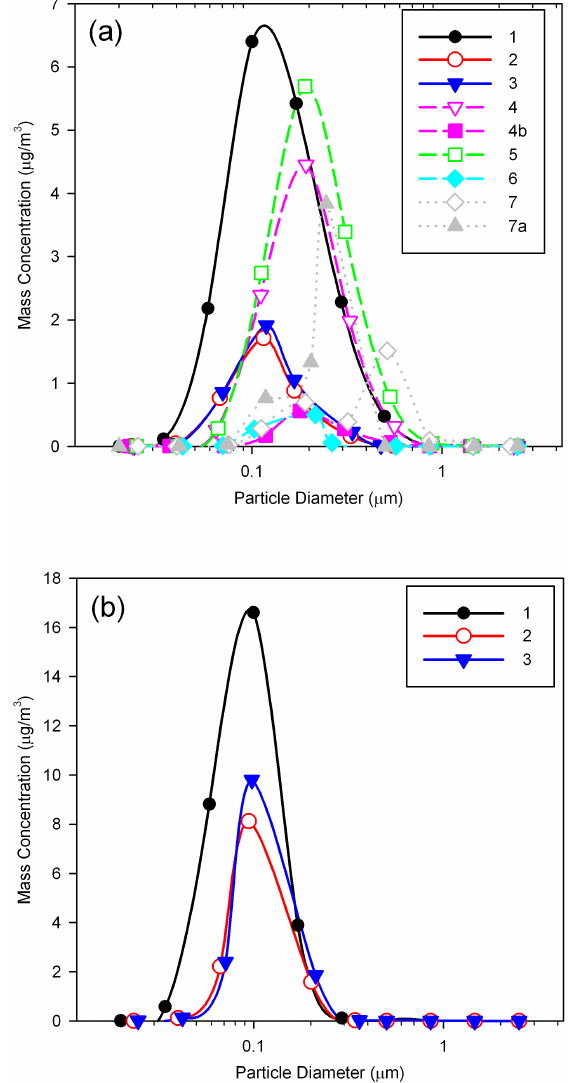
Fig. 5. Size distributions for external mixture aerosol populations formed at t =188 h in base case scenario simulations. (a) with coag- ulation, (b) without